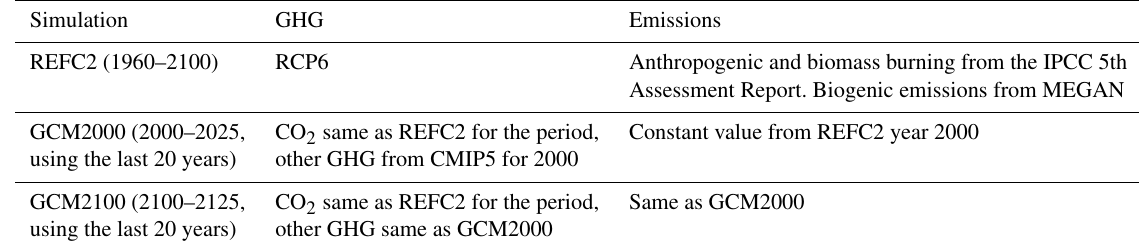
Table 1. CAM4-chem simulations used in this study. Simulation GHG Emissions